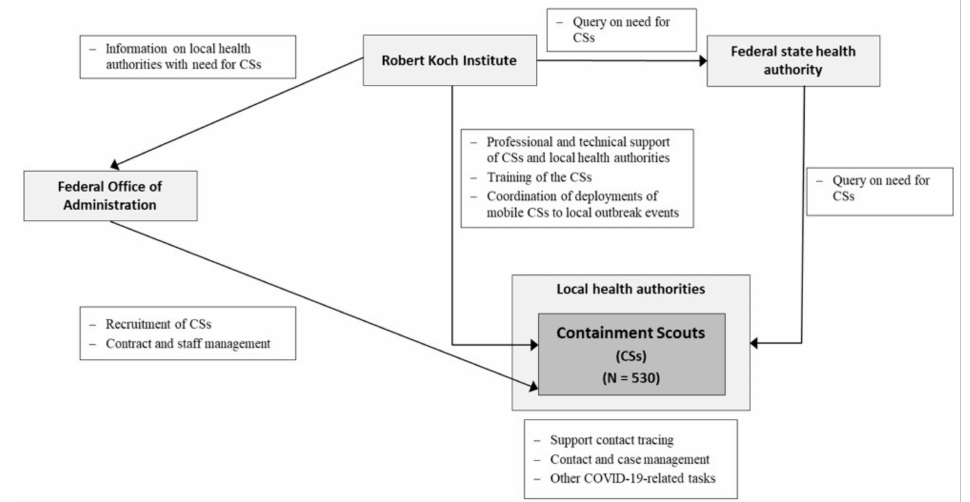
Figure 3. Containment Scout Initiative: Recruitment and